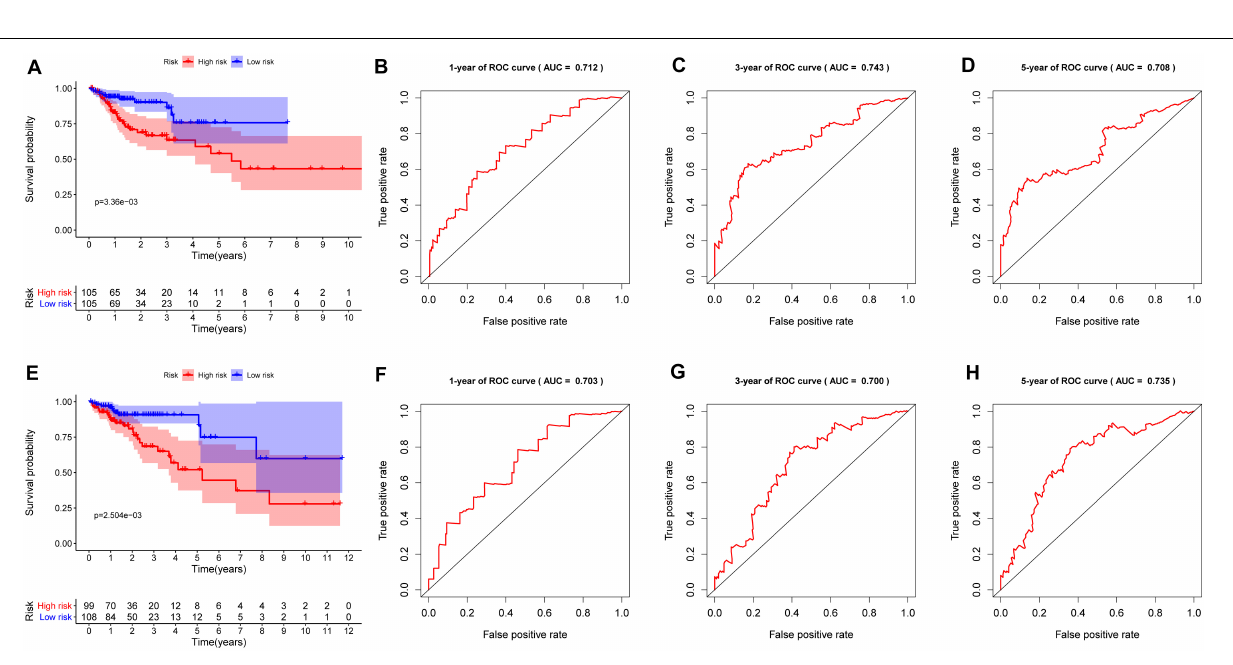
FIGURE 5 | Kaplan–Meier analysis and receiver operating characteristic (ROC) curve analysis in the training set and the testing set. (A) Kaplan–Meier analysis of the overall survival of patients in the high- and low-risk groups in the training set based on the RBP-related risk signature. (B) ROC curve for 1 year in the training set. (C) ROC curve for 3 years in the training set. (D) ROC curve for 5 years in the training set. (E) Kaplan–Meier analysis of the overall survival of patients in the high- and low-risk groups in the testing set based on the RBP-related risk signature. (F) ROC curve for 1 year in the testing set. (G) ROC curve for 3 years in the testing set. (H) ROC curve for 5 years in the testing